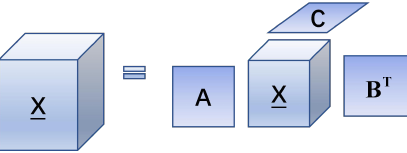
Figure 2. Tucker decomposition process.